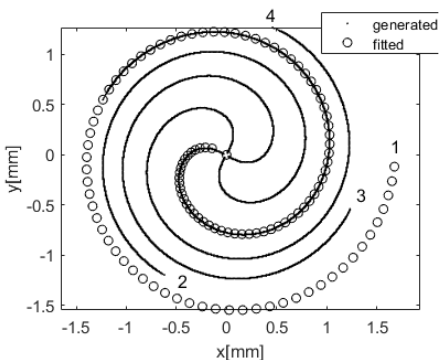
Figure 6. Results of fitting Fermat’s spirals to the LG beam with topological charge m = 4. Parameters of subsequent spirals are (95% confidence bounds). ( 1 ) Spiral 1, α = 3.497(3.492, 3.502) (1 / mm 2 ) and β = 2.635(2.629, 2.64); ( 2 ) Spiral 2, α = 3.447 (3.442, 3.452) (1 / mm 2 ) and β = − 2.045 ( − 2.051, − 2.039);